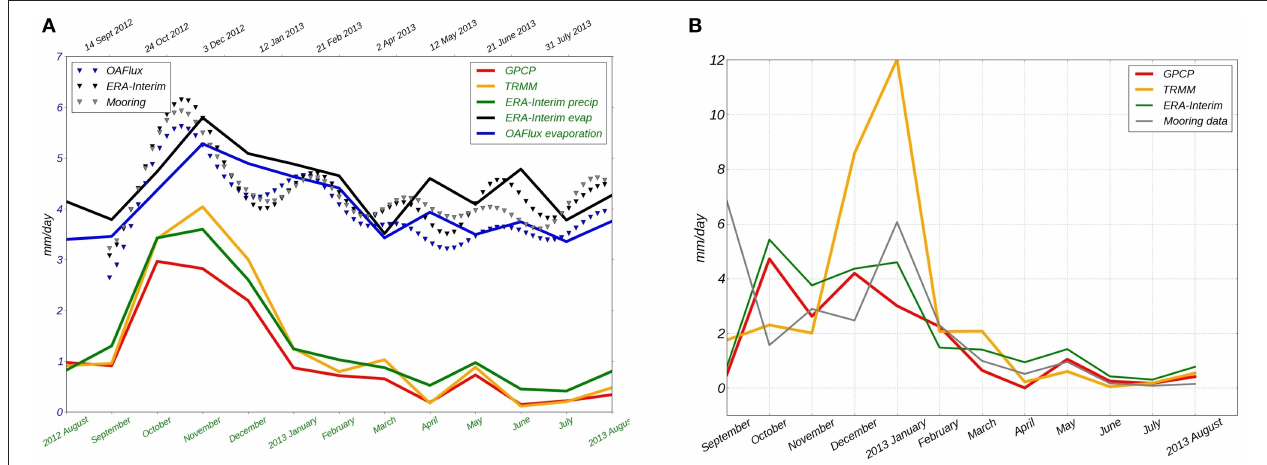
FIGURE 5 | (A) —Evaporation (ERA-Interim—black curve, OAFlux—blue) and precipitation (GPCP—red, TRMM—orange, ERA-Interim—green) data averaged over the month and over the domain (solid lines) and evaporation filtered with cut-off period 30 days at mooring position 24.5 ◦ N 38 ◦ W (dashed lines, mooring data—gray curve); (B) —precipitation data at mooring